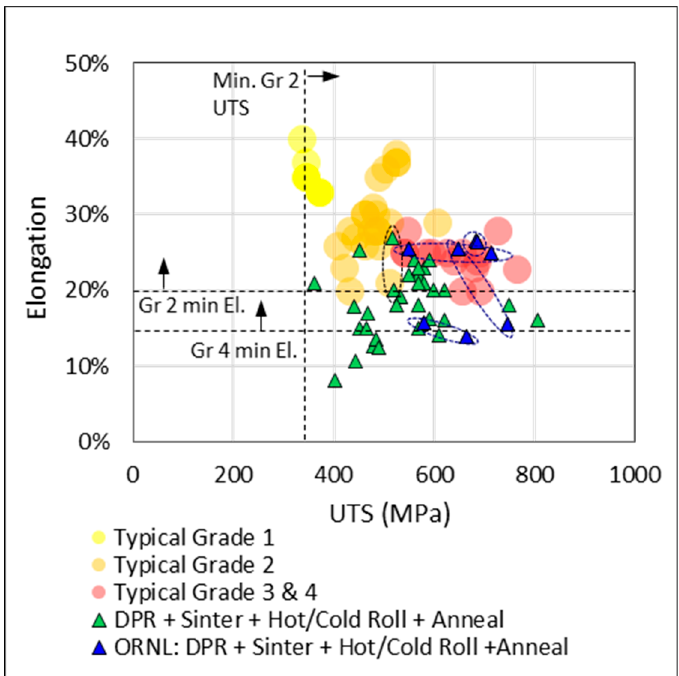
Figure 20. Elongation and UTS of fully processed DPR strip versus typical properties of grade 1–4 titanium. DPR: 8 sources (>2008).